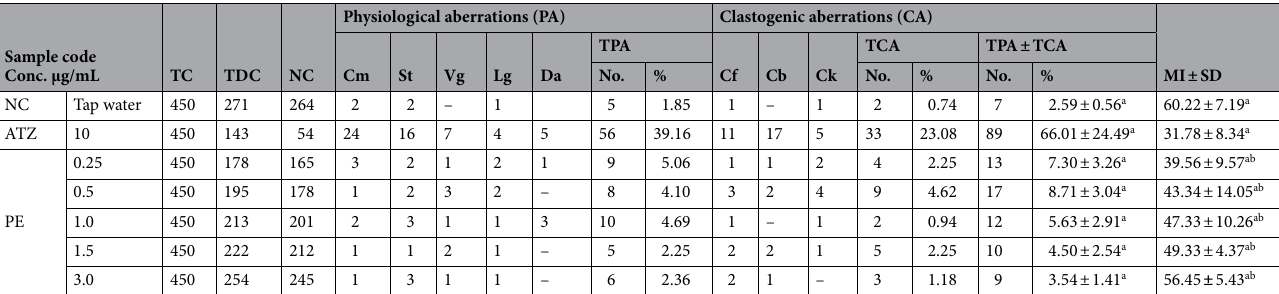
Table 6. Antigenotoxic potential of aqueous extract of leaves of Royale cinerea (D.Don) Baillon alone by Allium cepa root tip assay. NC negative control, ATZ atrazine, PE plant extract, TC total cells, TDC